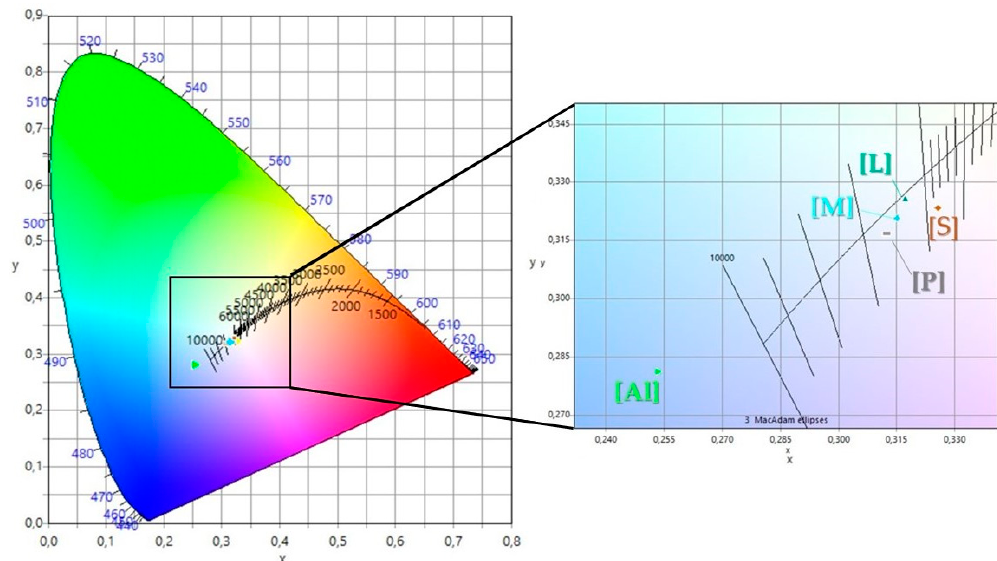
Figure 5. Colorimetric parameters displayed on a CIE diagram, including the sRGB region for the inorganic fillers loaded with flavonoids.